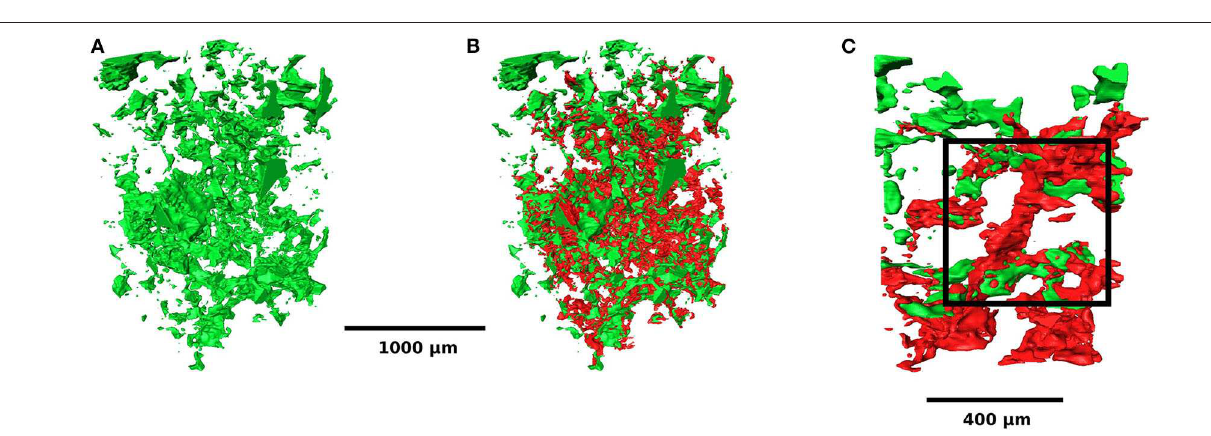
FIGURE 3 | Volume rendering visualization of the influence of cement on the pore network. Shown in sample BFS6 where green is macroporosity and red is microporosity. The poorly connected macroporosity is shown in isolation in (A) . The proportion of both macro and microporosity is shown in (B) . The microporous cement phase can effectively fill some channels between larger clusters of macropores (C)